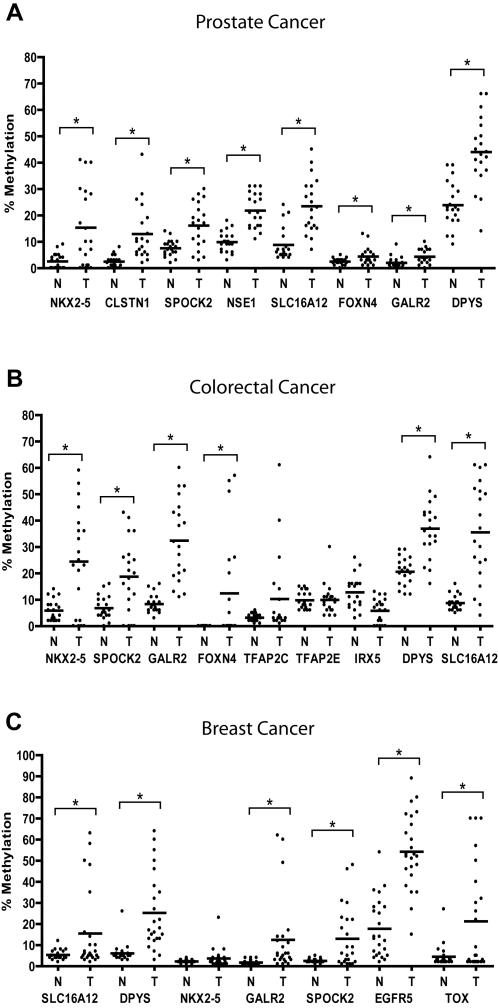
Scatter plots of methylation analysis in primary prostate cancer (A), colorectal cancer (B) and breast cancer (C).N and T represent tumor and adjacent normal. *Significantly different from normal adjacent samples, P<0.05.